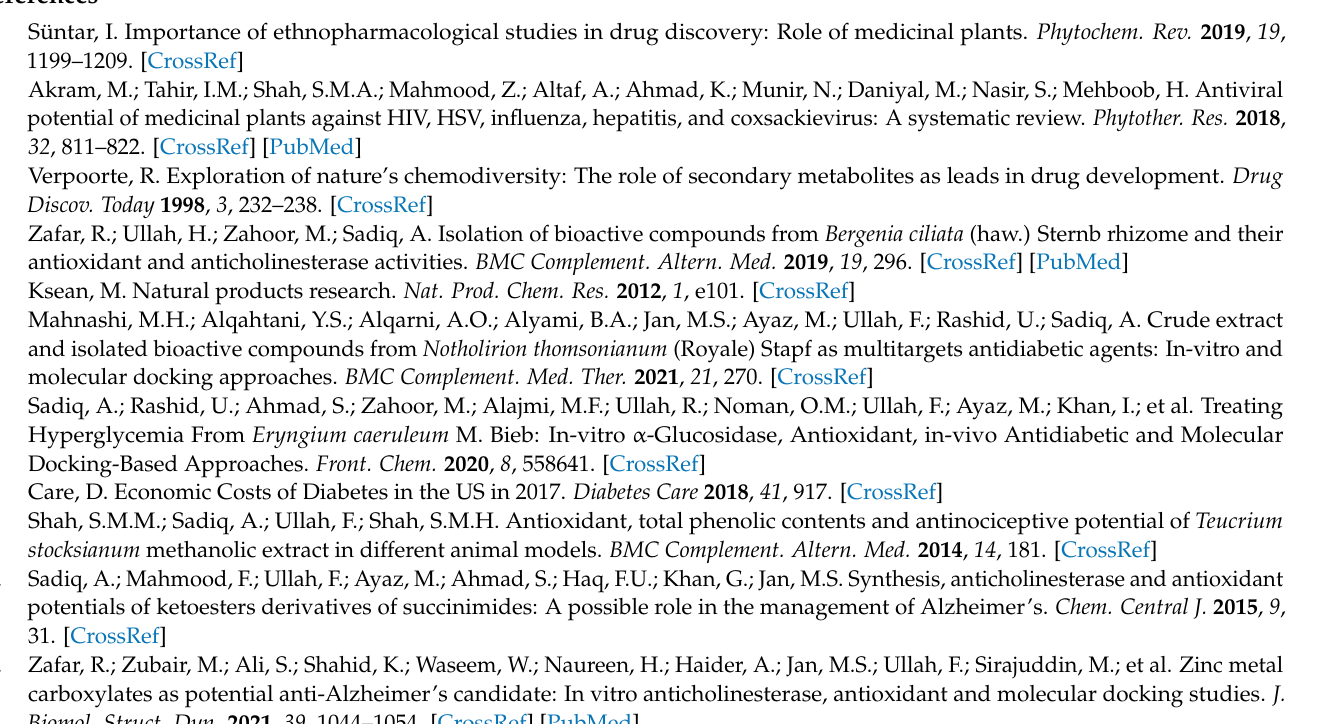
Figure S1: GC-MS chromatogram of Compound 1 ; Figure S2: 1 H-NMR spectrum of Compound 1 ; Figure S3: 13 C-NMR spectrum of Compound 1 ; Figure S4: GC-MS chromatogram of Compound 2 ; Figure S5: 1 H-NMR spectrum of Compound 2 ; Figure S6: 13 C-NMR spectrum of Compound 2